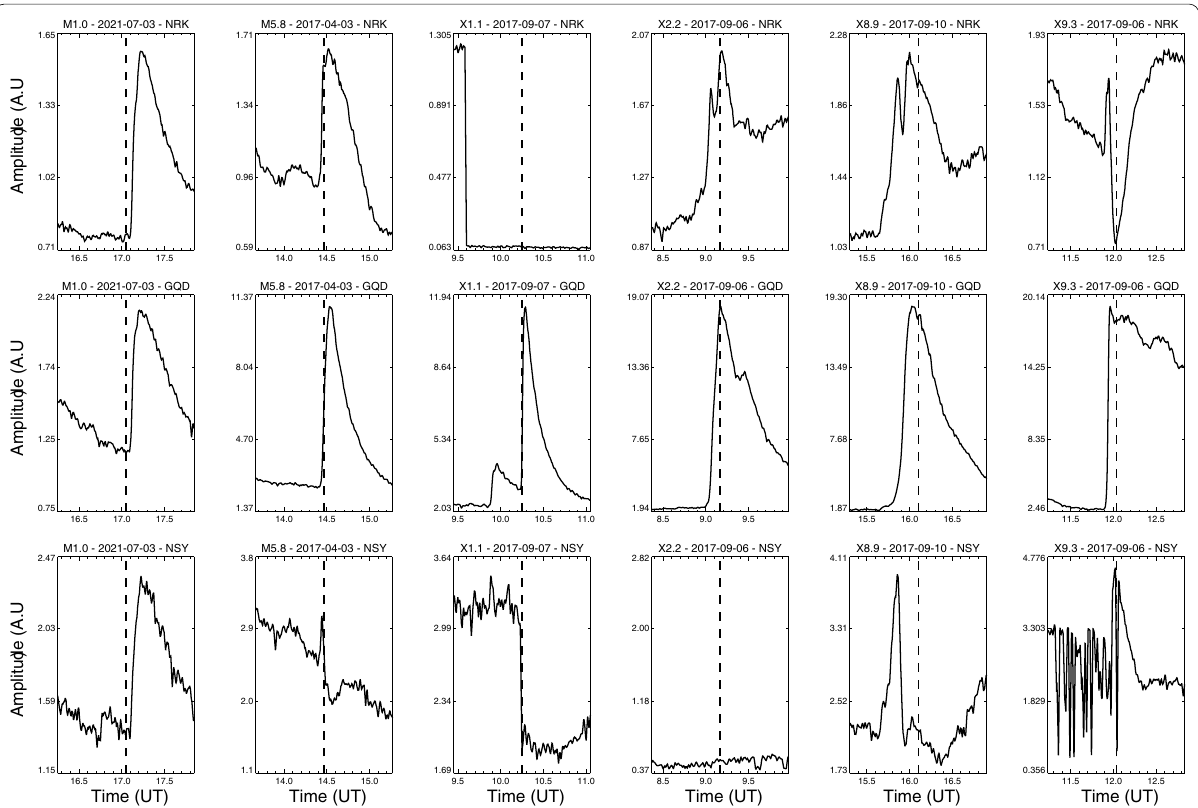
Fig. 2 Time profiles for several flares of increasing strength (column) and GQD, NRK and NSY (from top to bottom row). Vertical dashed lines indicate the flare peak time (as given by the GOES daily reports). Amplitudes are given in arbitrary units. NRK was off-air for the X1.1 flare, while NSY was off-air during the X2.2 and